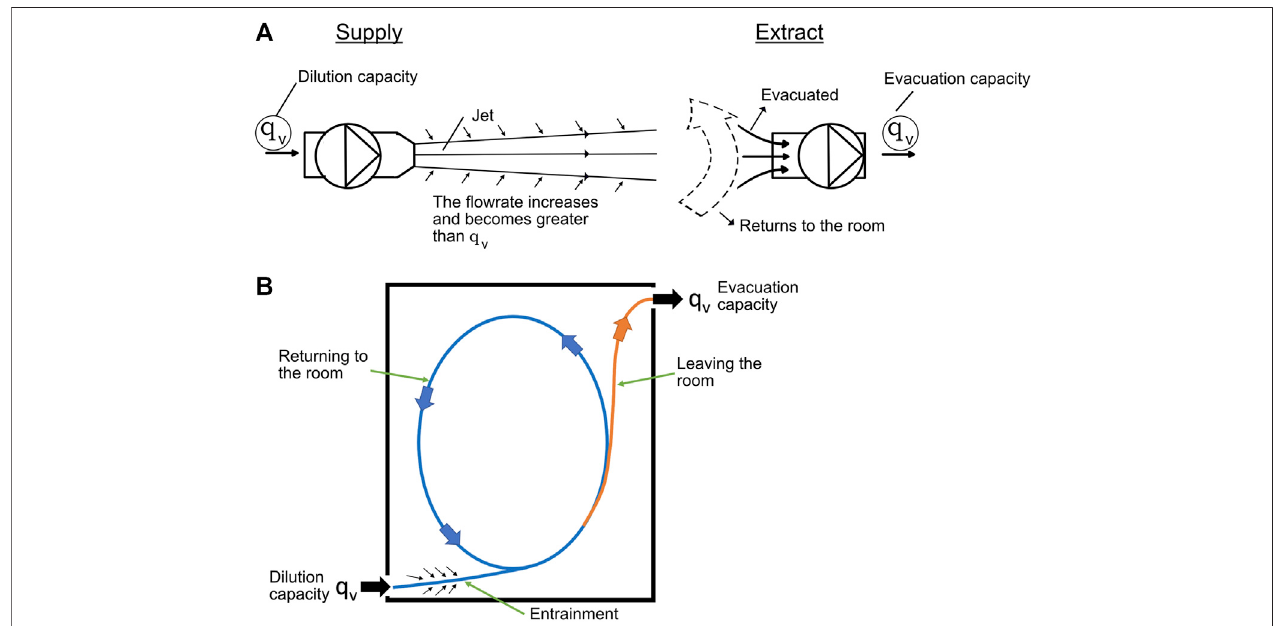
FIGURE 2 | (A) Generation of an excess fl ow rate returning to the room when the evacuation capacity is less than the internal fl ow rate. (B) Sketch of the resulting fl ow rate in the room when the evacuation capacity is less than the internal fl ow rate.